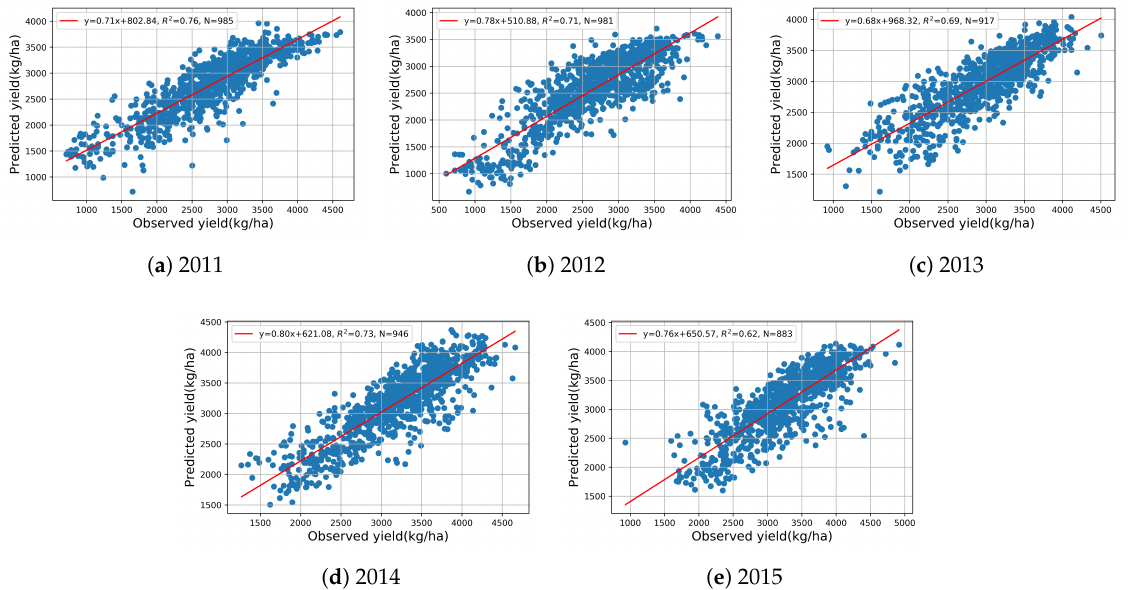
Figure 9. CNN-LSTM in-season predicted vs. observed soybean yield on AUG 21st from 2011 to